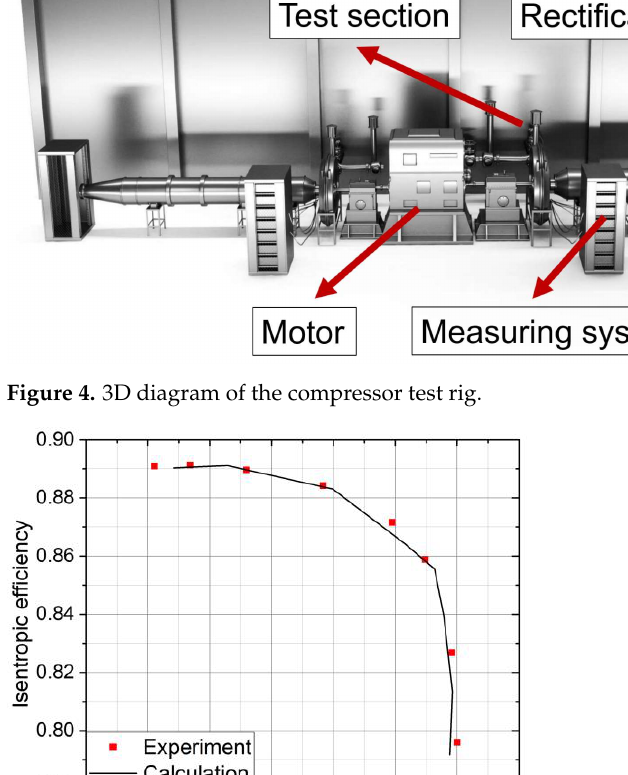
Figure 5. Comparison of compressor isentropic efficiency and total pressure ratio between experi- mental and numerical results. 3. Results and Analysis 3.1. Effect of Wake on Compressor Performance at Different Re Eight cases with and without a wake were calculated at Re values from 1 × 10 5 to 4 × 10 5 . The corrected mass flow and the corrected rotating speed of different cases remained the same. Because unsteady numerical simulations were used in the cases with the wake, many related results presented here have been time averaged. Based on Equation (1), the isentropic efficiency of the rotor with and without the wake at different Re is shown in Figure 6. Clearly, both the Re value and wake influence the rotor efficiency. The rotor is less efficient and the efficiency declines sharply at lower Re, which indicates that the Re effect is significantly enhanced at low Re, resulting in a large change in the flow charac- teristics and performance of the compressor. By comparing the operating conditions with and without wake, it can be seen that the change of Re will make the impact of wake on performance different. The unsteady wake has a beneficial effect on the efficiency of the rotor at Re = 4 × 10 5 , but this effect weakens as Re decreases until the effect is negative. To quantitatively analyze the flow loss in different regions, the blockage coefficient of 10% chord length section after the rotor under different conditions is shown in Figure 7. The blockage coefficient is defined by Yu et al. [37] as B m = m b m t = ρ ∬ (V ext −V)dA A m t (2) where m b and m t are respectively the reduced mass flow due to the flow blockage and the actual total mass flow; V is the streamwise velocity; V ext is the average streamwise velocity at the boundary of the blockage region; A is the total area of the blockage region. Accord- ing to Equation (2), the key to obtaining the blockage coefficient is to determine the